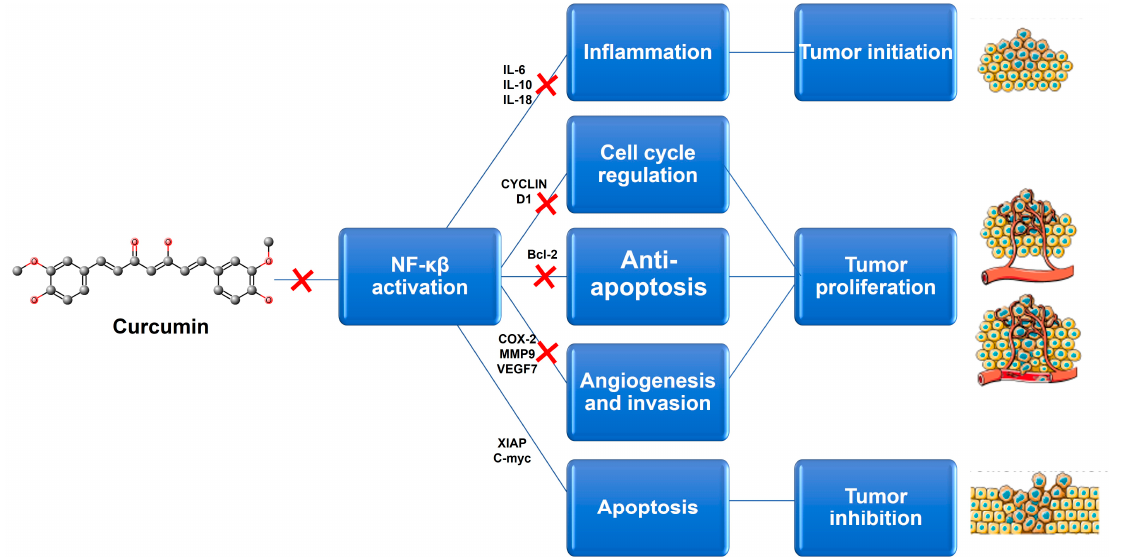
Figure 4. Potential targets associated with Curcumin anticancer activity. This natural compound induces a reduction in its target genes by inhibiting NF-k β signaling. Bcl-2-B-cell limphoma-2; COX-2-ciclo-oxigenase-2; IL-6-interleukin 6; IL-10-interleukin 10; IL-18-interleukin 18; MMP9-matrix metallopeptidase 9; NF-k β -nuclear factor kappa B; VEGF-vascular endothelial growth factor; XIAP-X-linked inhibitor of apoptosis protein.